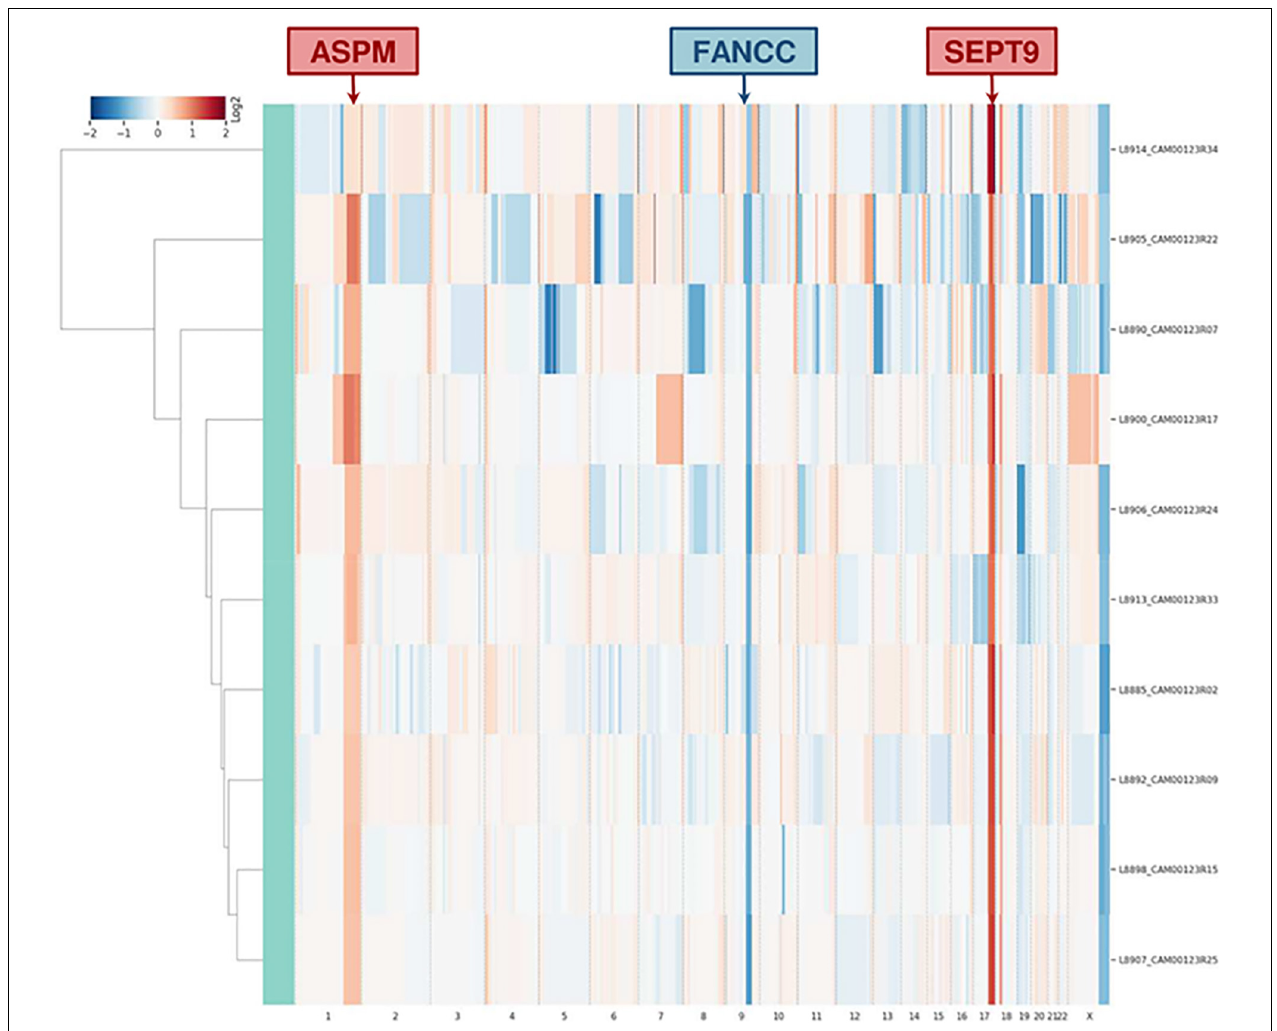
FIGURE 5 | Clustering analysis of 10 CTCs based on whole-genome copy number profile. The heatmap represents the relative copy number profiles of 10 different CTCs isolated through CELLSEARCH R (cid:13) and DEPArrayTM technologies. Segments of gains or deletions are color-coded according their relative log2 copy number